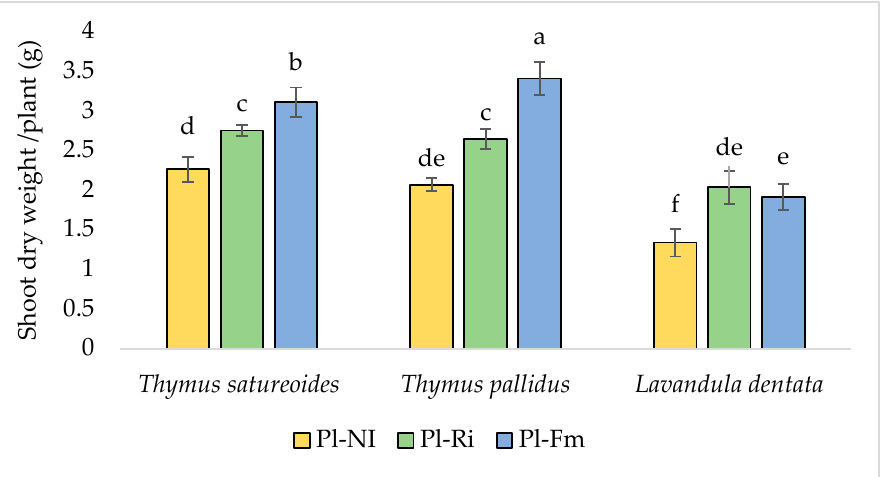
Figure 2. Shoot dry matter (SDM) per plant of Thymus satureioides (Ts), Thymus pallidus (Tp), and Lavandula dentata (Ld), non-inoculated (NI) or inoculated with Rhizophagus irregularis (Ri) or Funneliformis mosseae (Fm) after 4 months of culture under greenhouse conditions. Bars followed by the same letter are not significantly different according to Tukey’s HSD test ( p < 0.05).